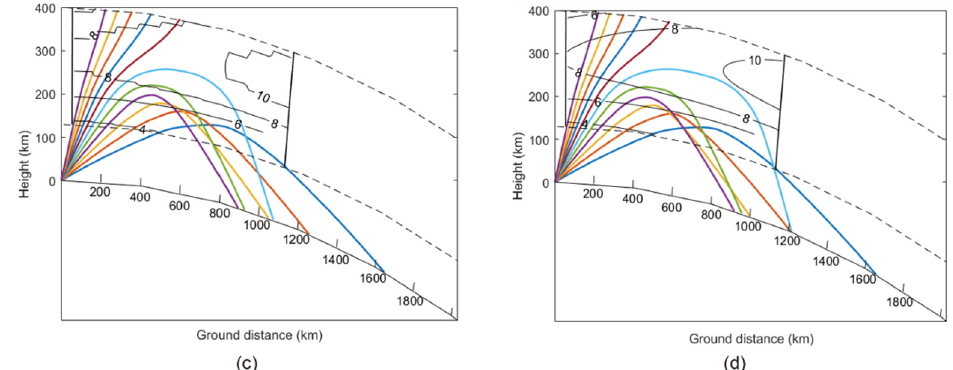
Figure 9. Ray tracing results: ( a ) real data, ( b ) conventional GA, ( c ) neighborhood-aided correction and ( d ) neighborhood-aided correction and local region multistep